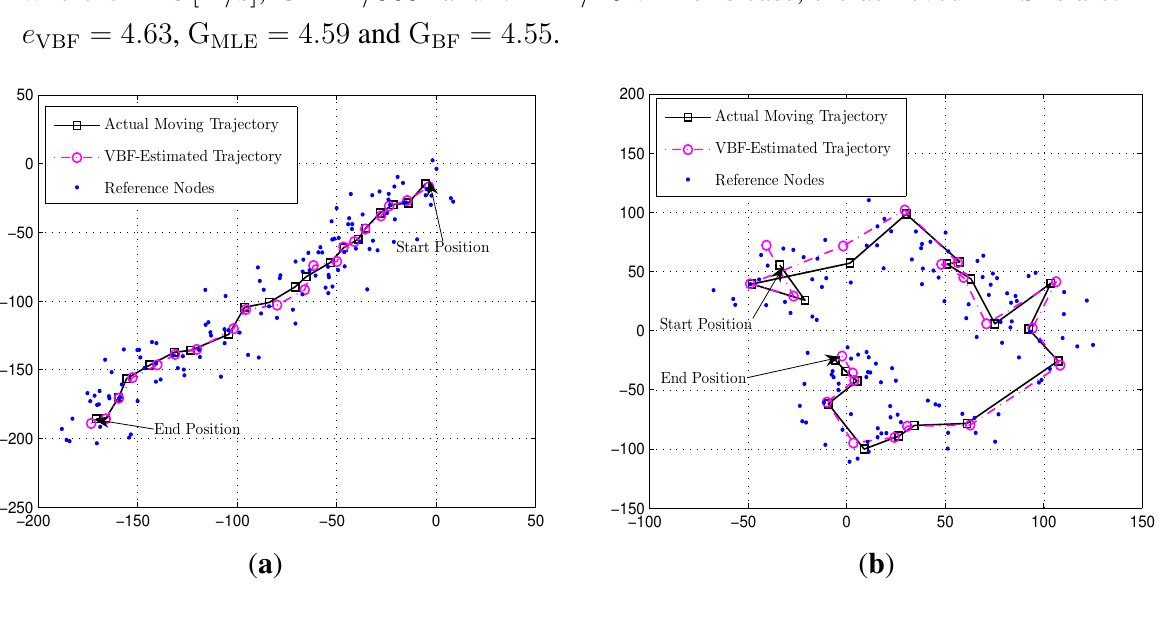
= 6 . Other t = 3 . 24 , VBF